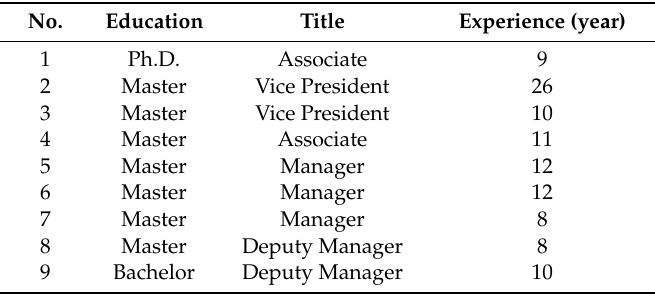
Table 4. Experts’